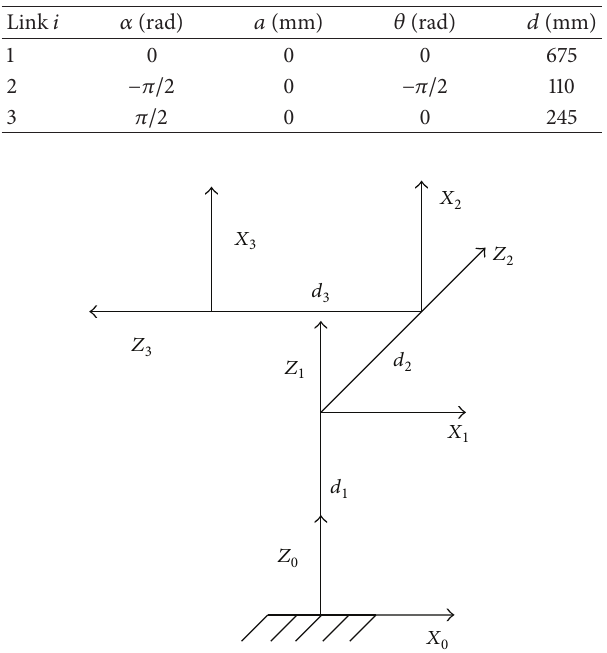
Figure 3: 3-DOF manipulator’s D-H coordinate